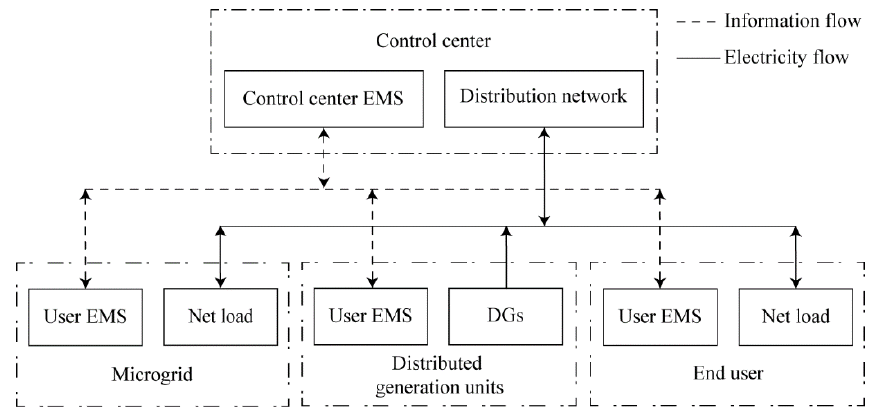
Figure 4. Structure of the distribution network optimal control system.